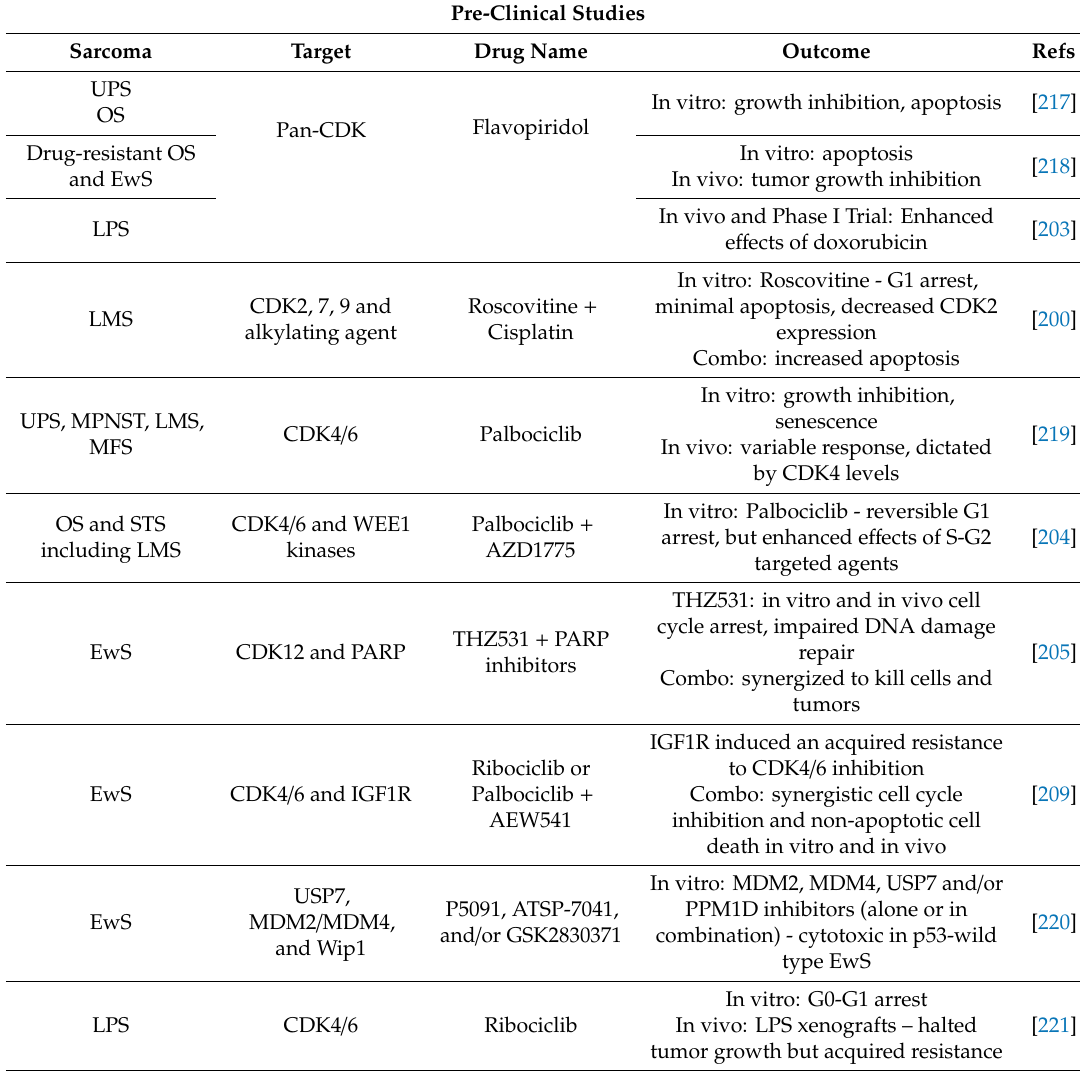
Table 3. CDK-targeted therapy in